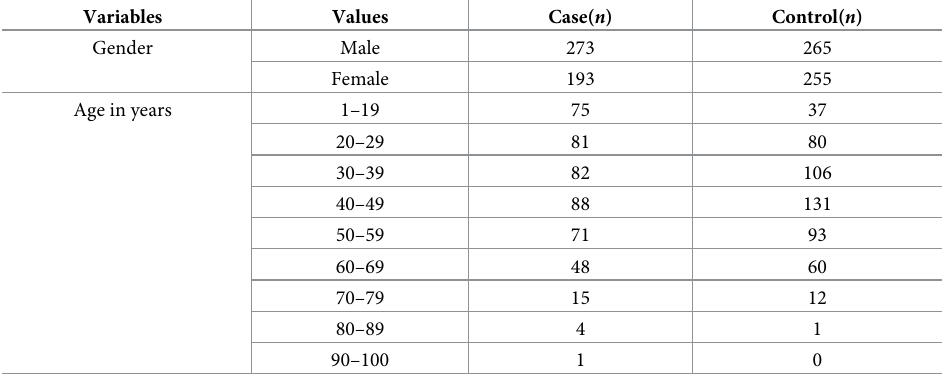
Table 1. Demographic characteristics of 920